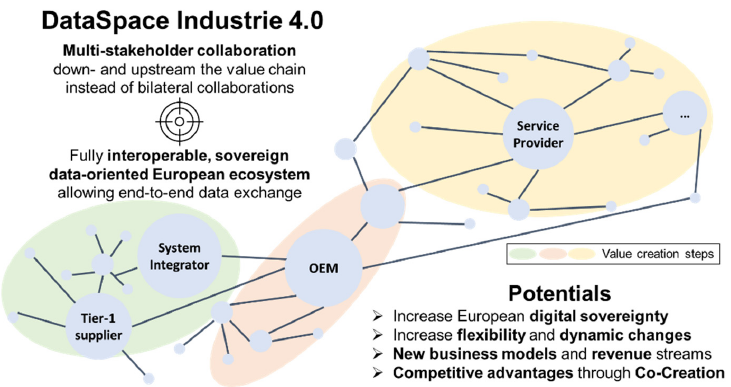
Figure 2. DataSpace Industrie 4.0—Initiative for a sovereign European industrial data ecosystem (own illustration based on Plattform Industrie 4.0 [56]).